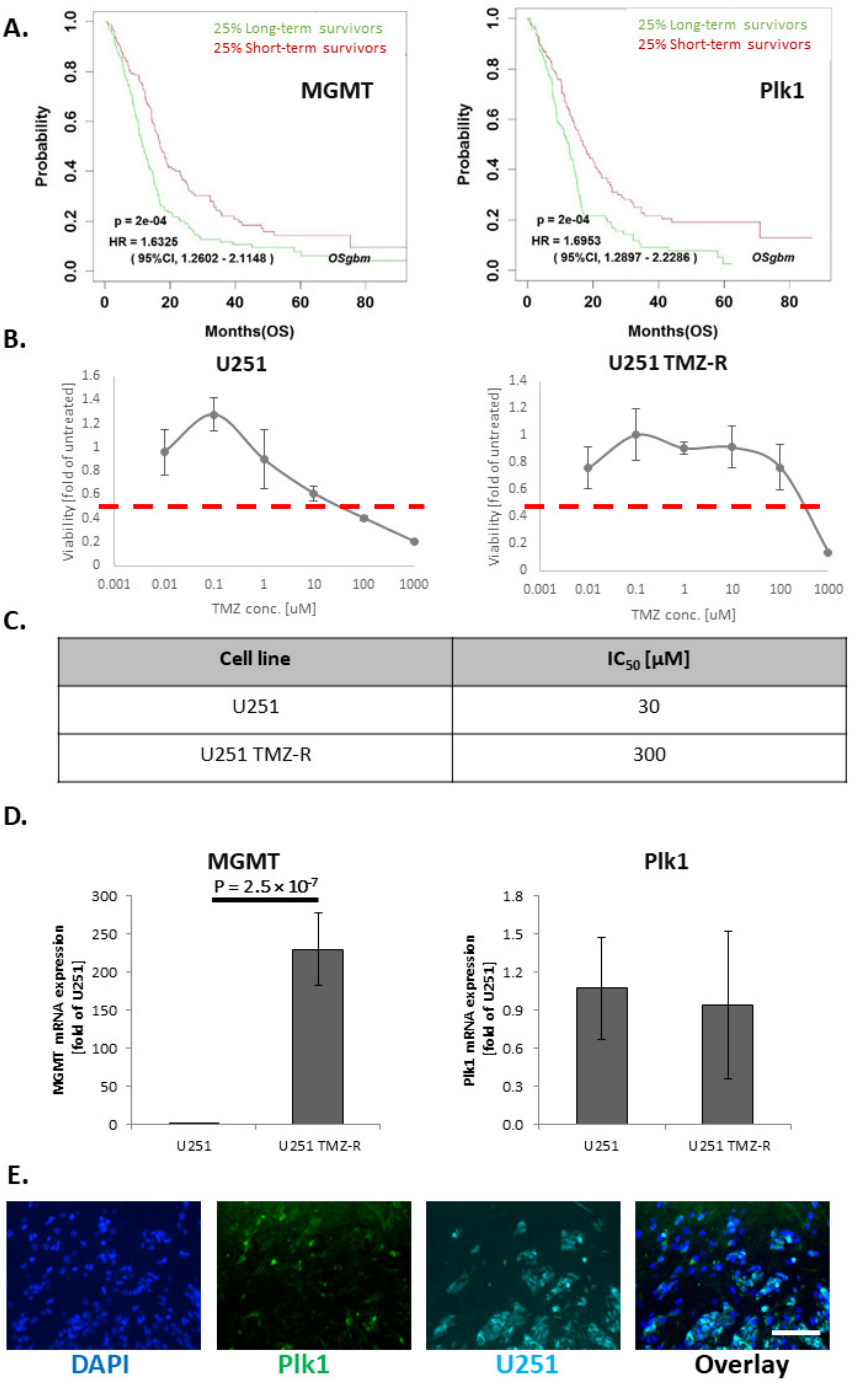
Figure 1. The development of resistance to TMZ enhances MGMT expression without altering Plk1 oncogene levels in GB. ( A ) Survival analysis performed on OSgbm database comparing MGMT expression (left panel) and Plk1 expression (right panel) of the top 25% longest GB survivors versus the bottom 25% shortest survivors. ( B ) Inhibitory concentration 50% (IC 50 ) plot of parental U251 glioblastoma cells vs. TMZR clone. ( C ) Table summarizing the IC 50 of wild-type U251 cells versus U251 TMZ-R cells. ( D ) TMZ resistance in U251 occurred via upregulation of MGMT, without changing Plk1 levels. ( E ) Intracranial U251 GB tumors show Plk1 expression (scale = 100 µ